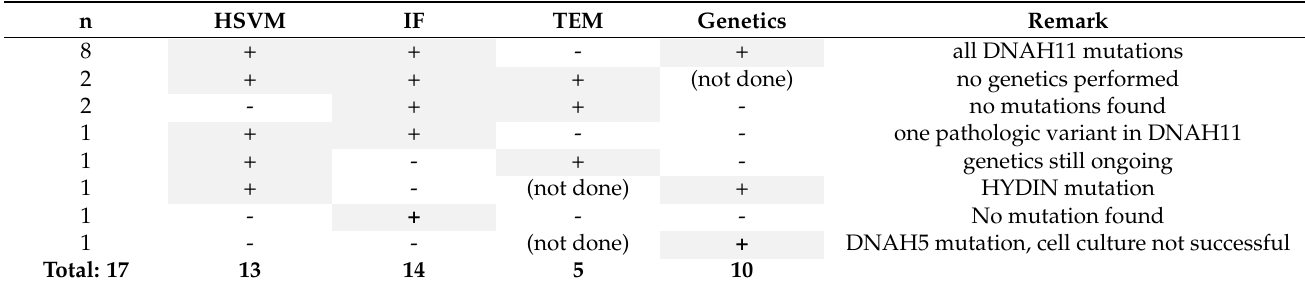
n = number of patients, written in bold = the sole method leading to the diagnosis of PCD. + = the outcome of this method was leading to the diagnosis of PCD. - = the outcome of this method was neither “high evidence for PCD” nor “PCD positive” and, thus, was NOT leading to the diagnosis of PCD.